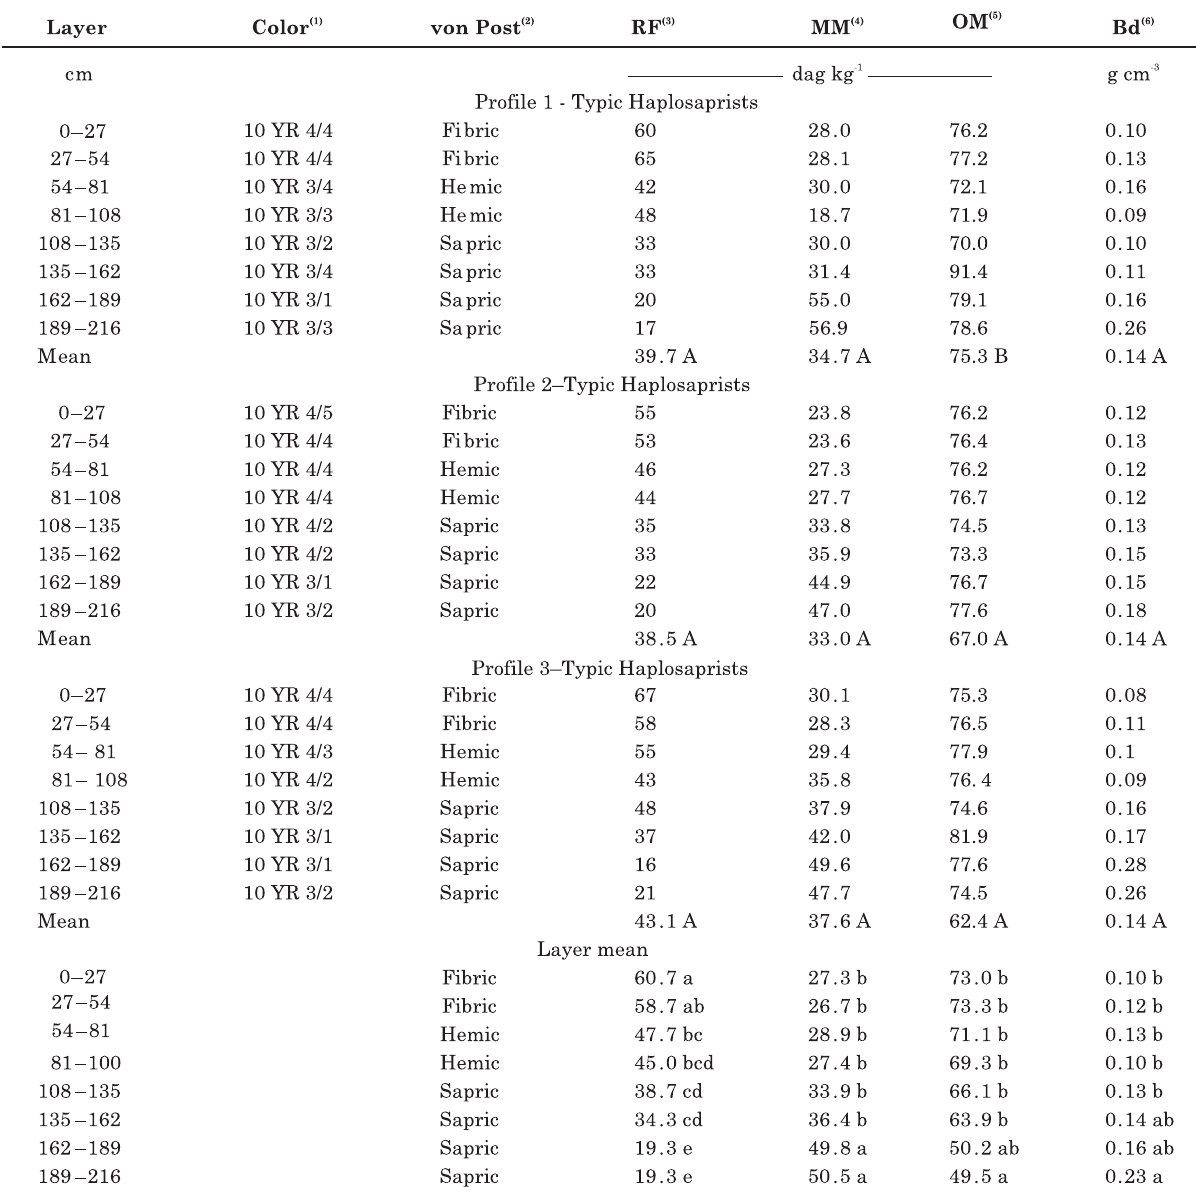
Table 3. Physical and chemical properties of three peatland profiles in the conservation unit Pau-de-Fruta, Diamantina,